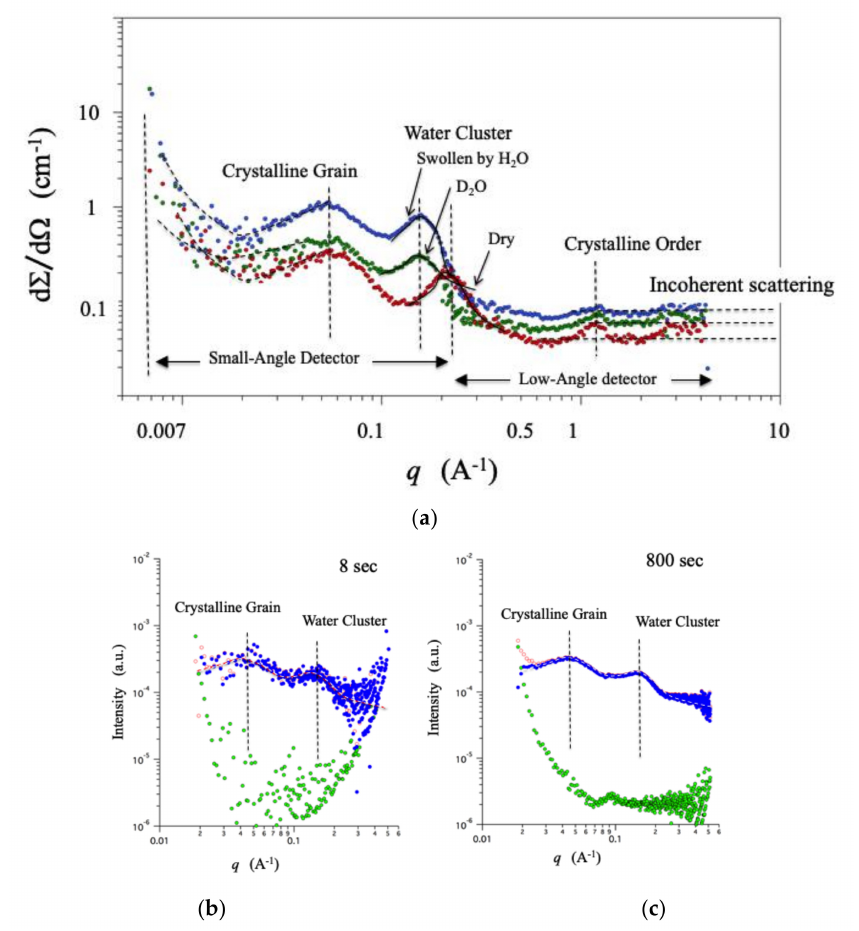
Figure 13. ( a ) Scattering profiles obtained for polymer thin film (Nafion ® ) at a dry state (red), or a swollen state with H 2 O or D 2 O (blue or green, respectively). ( b , c ) Time-dependent scattering obtained for thin film (Nafion ® ) (blue) and background (green) after histograms for 8 s and 800